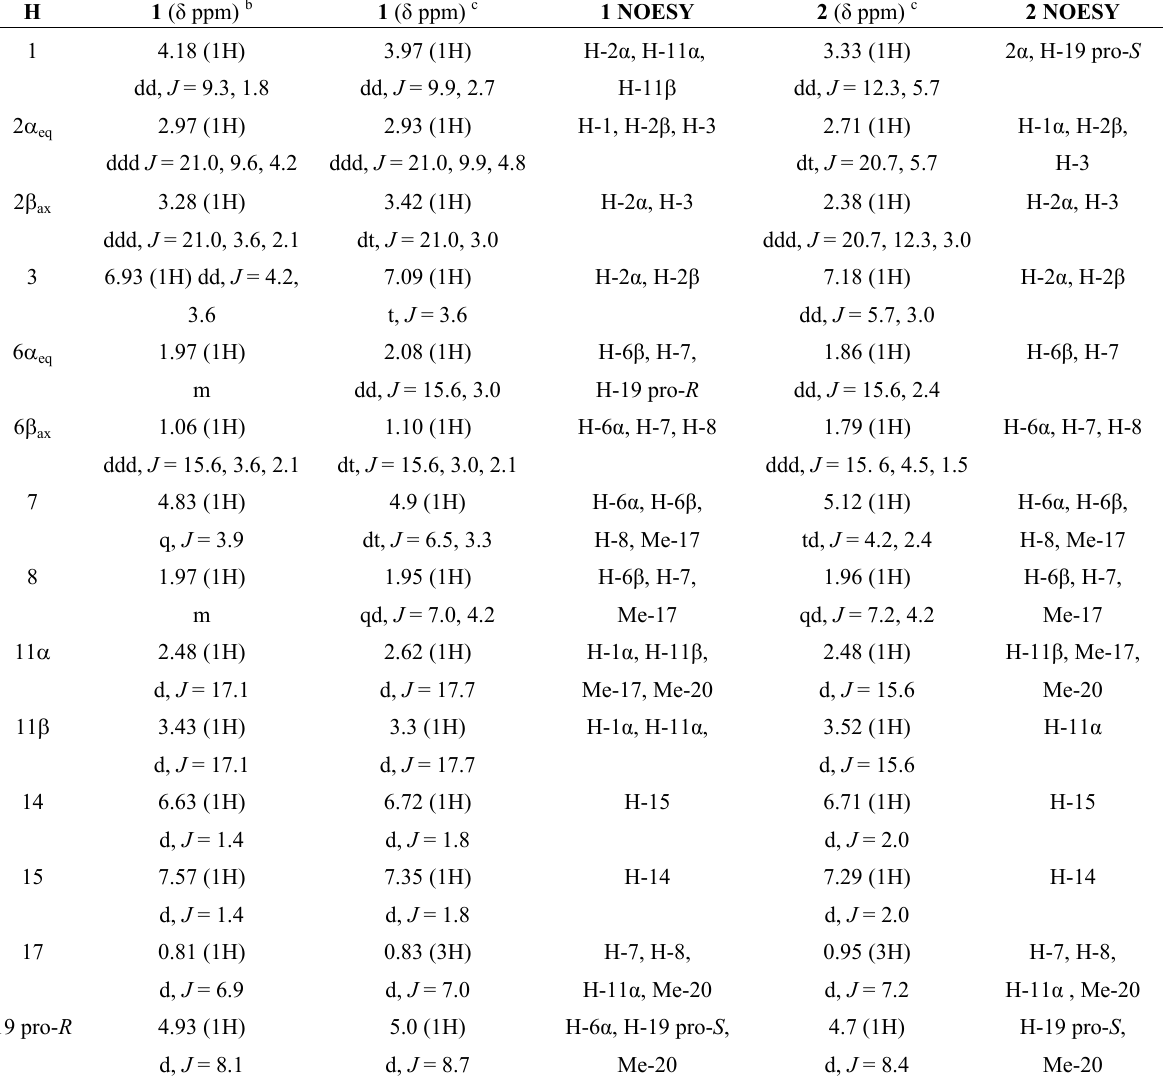
Table 1. 1 H-NMR data for compounds 1 and 2 . (300 MHz, TMS, J = Hz) a